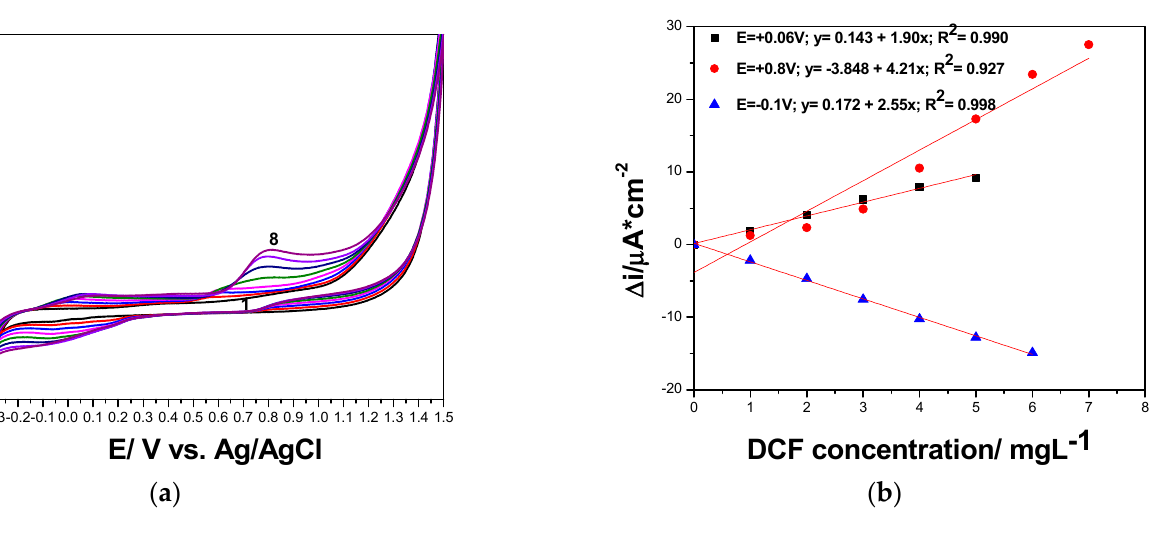
Figure 2. ( a ) Cyclic voltammograms recorded at CNT paste electrode with the scan rate of 0.050 V·s − 1 in 0.100 M Na 2 SO 4 supporting electrolyte (curve 1), and DCF concentrations ranged from 1.00 to 7.00 mg·L − 1 (curve 2–8). ( b ) Calibrations plots of peak current vs. DCF concentrations at the potential value: E = +0.060 V vs. Ag/AgCl (anodic), E = +0.800 V vs. Ag/AgCl (anodic), and E = − 0.100 V vs. Ag/AgCl (cathodic).